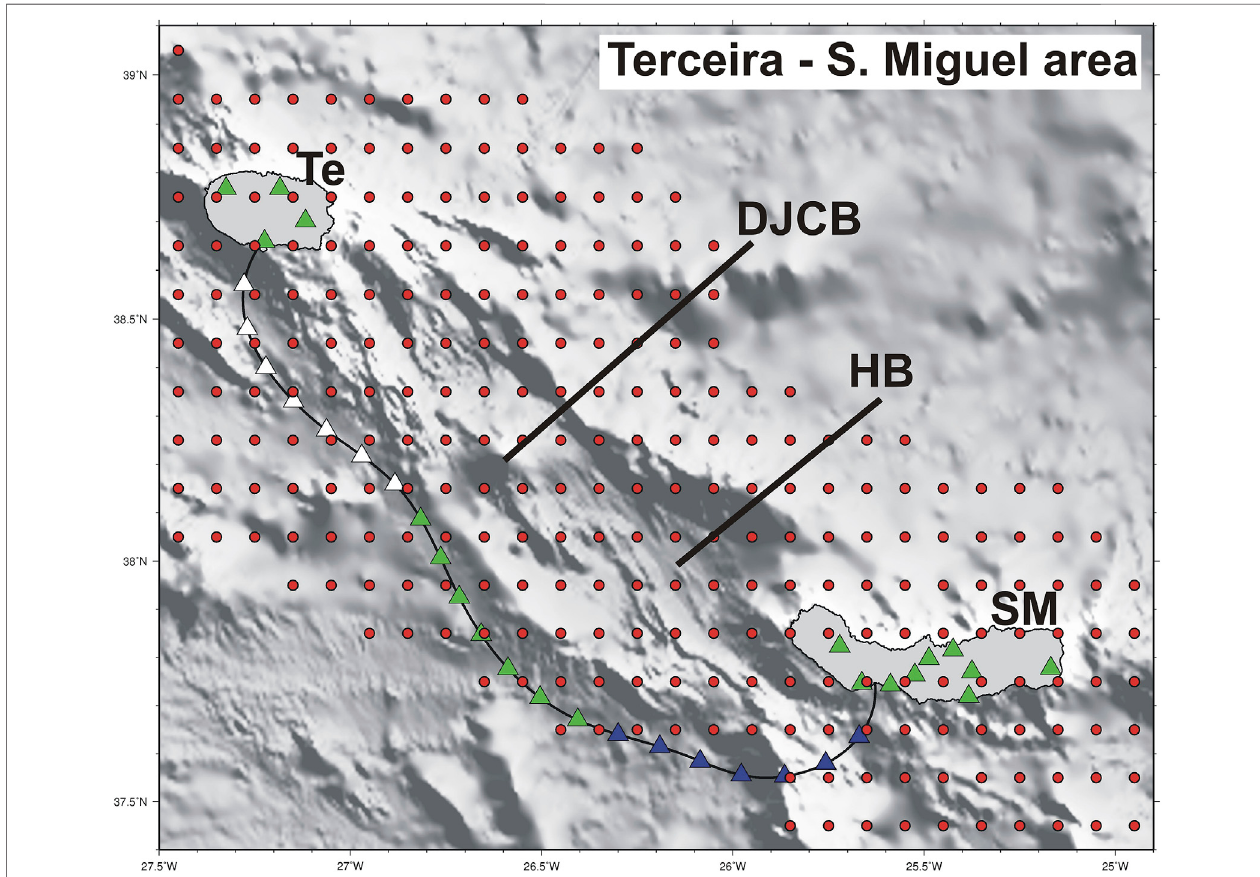
FIGURE 4 | Layout of sensors and sources for the investigation of the DAS contribution to the monitoring of earthquakes in the Azores. Red dots show the epicentersyntheticlocations,aregulargridwith0.1 ° interval.ThegreentrianglesonlandshowtheexistingseismicstationsoperatedbyIPMA.Blacklineisthepresumed location of the Terceira-S. Miguel submarine cable, along which the colored triangles show the virtual seismic stations spaced every 10 km. The location strategy adopted considers the cable split into 3 segments that are identi fi ed with different colors. Te – Terceira Island, SM – S. Miguel Island, DJCB – D. João de Castro Bank, HB – Hirondelle